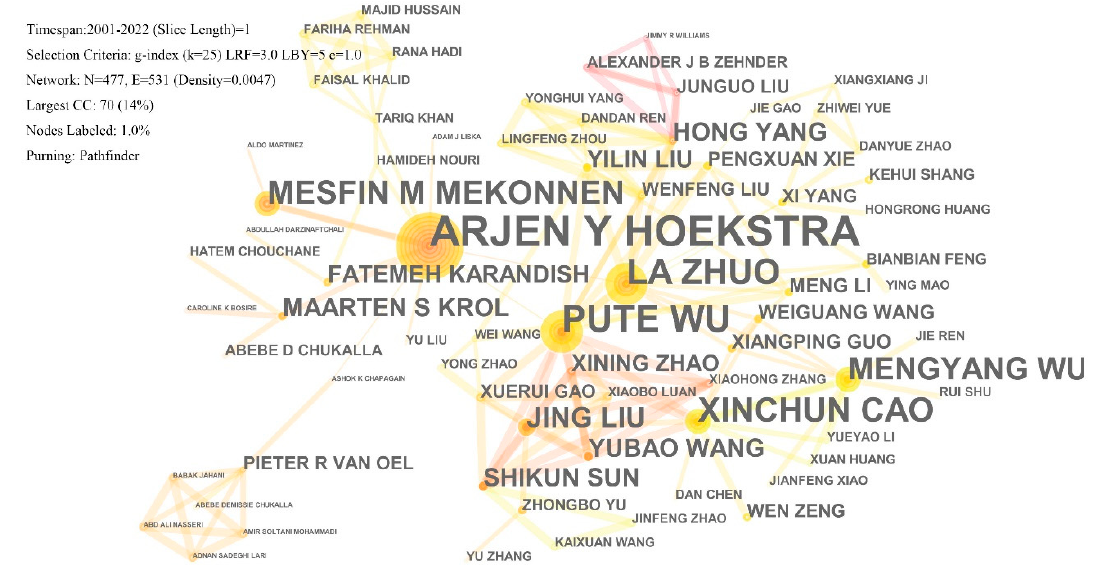
Figure 5. Cooperation network of authors.